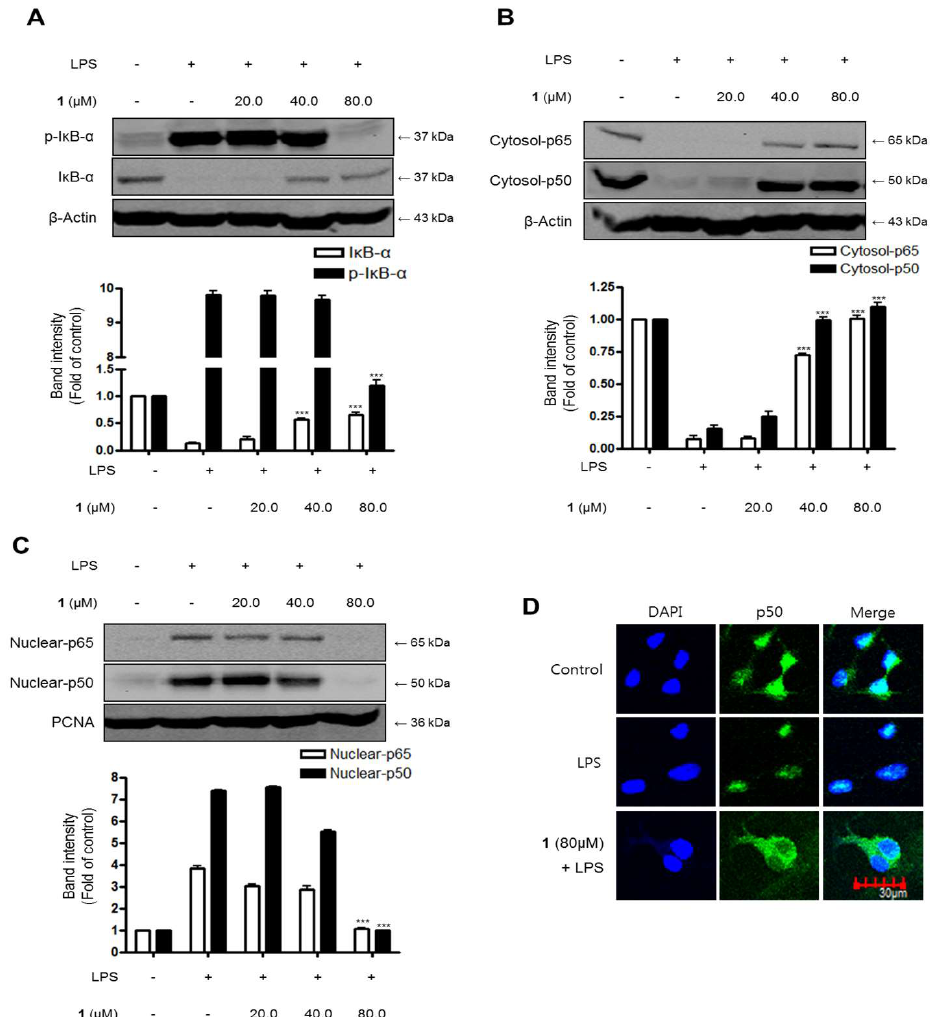
Figure 9. The effects of steppogenin ( 1 ) on I κ B- α phosphorylation and degradation ( A ), NF- κ B activation ( B , C ), and NF- κ B localization ( D ) in LPS-stimulated primary rat microglial cells. ( A – D ) The cells were pretreated for 3 h with the indicated concentrations of 1 and then stimulated for 1 h with LPS (1 µ g/mL). Total proteins were prepared and the western blot analysis was performed using specific I κ B- α , p-I κ B- α p65, and p50 antibodies. A commercially available NF- κ B ELISA (Active Motif) was used to test the nuclear extracts and determine the degree of NF- κ B binding. The data are presented as the mean ± SD of three experiments. The band intensities were quantified by densitometry and normalized to the intensity of β -actin or PCNA; the normalized values are presented below each band.